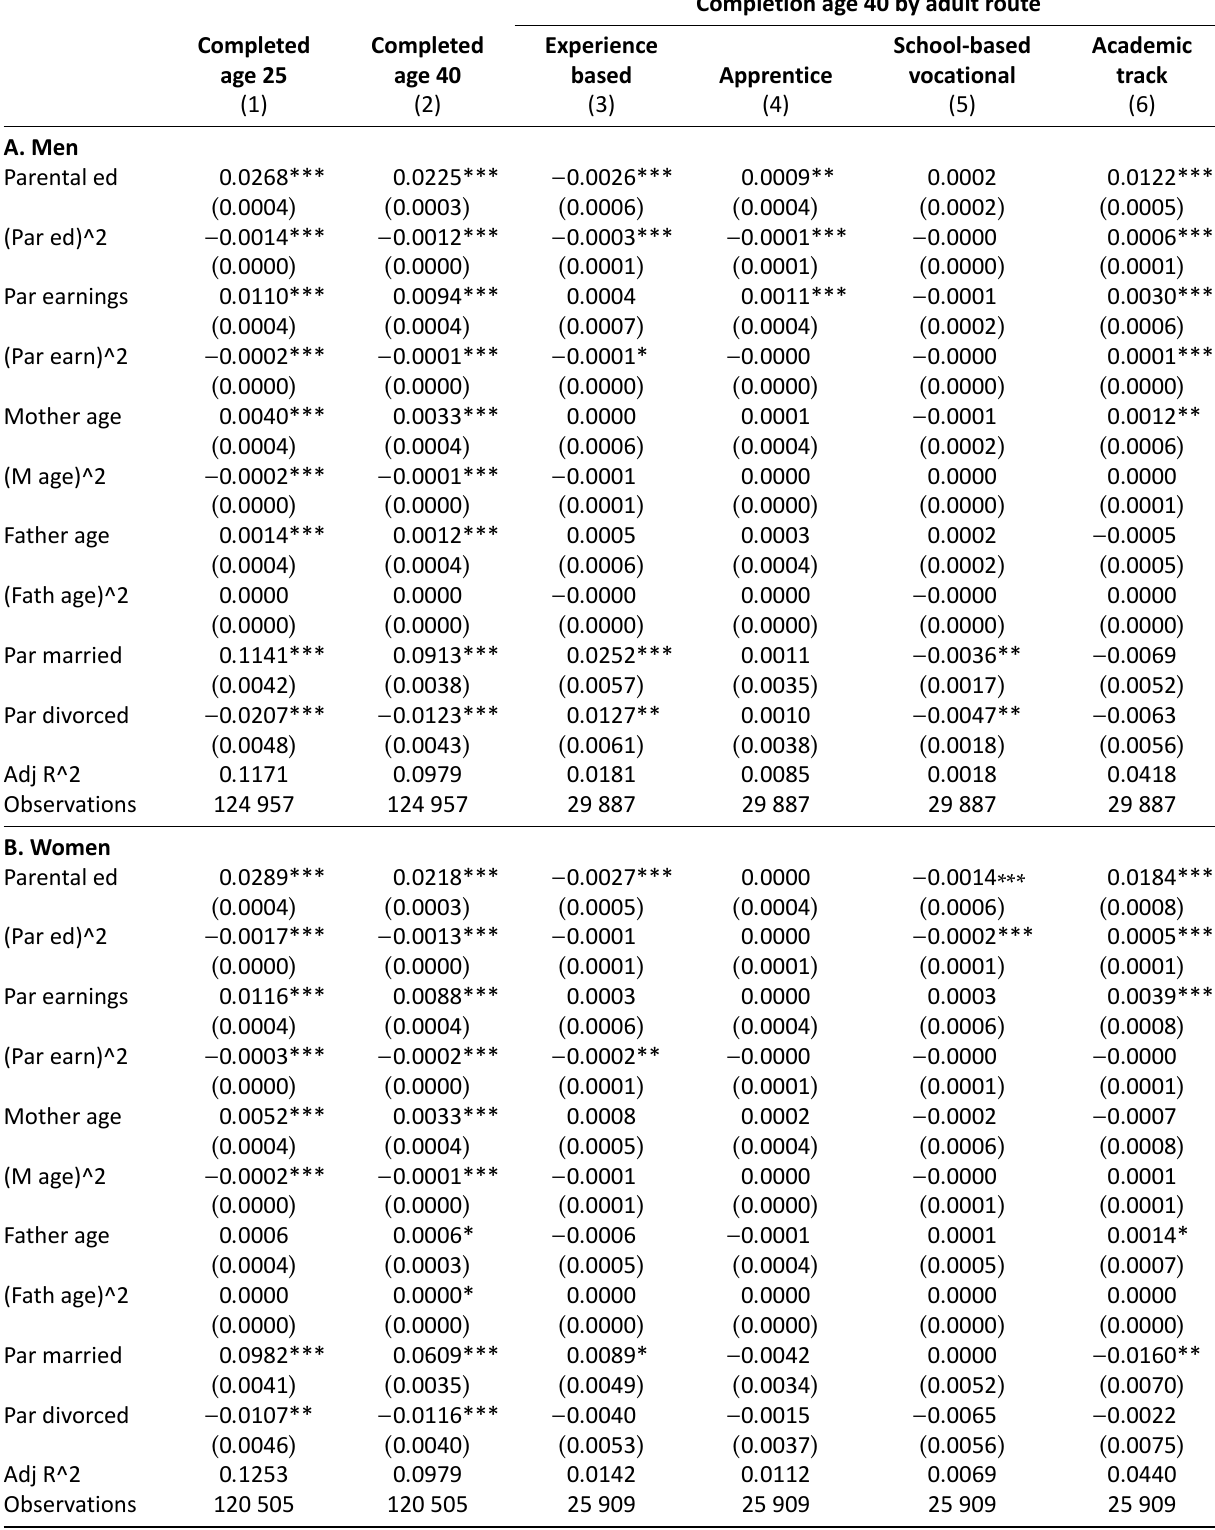
Table A3. Completion of upper secondary education; extended parental background